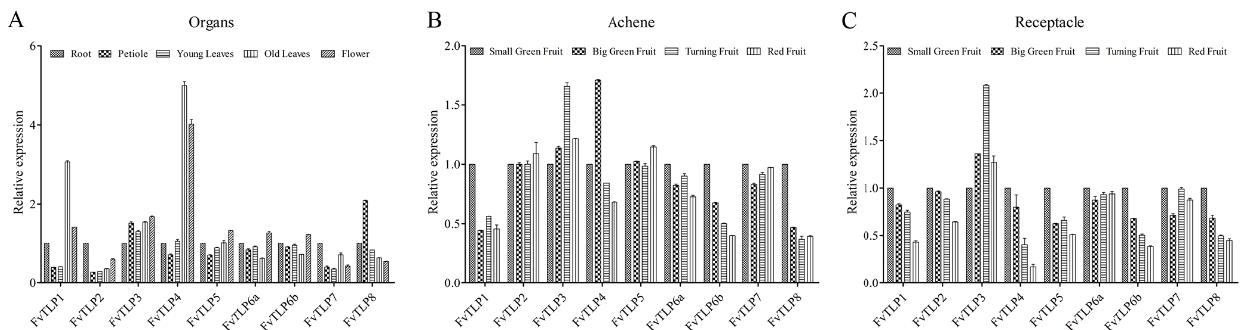
Figure 7. Expression patterns of TLP genes in Fragaria vesca . ( A ) Expression profiles of FvTLP s in different tissues (root, petiole, young leaves, old leaves and flower). Expression profiles of FvTLP s in achene ( B ) and receptacle ( C ) at different stages of fruit development (small green, big green, turning, and red).